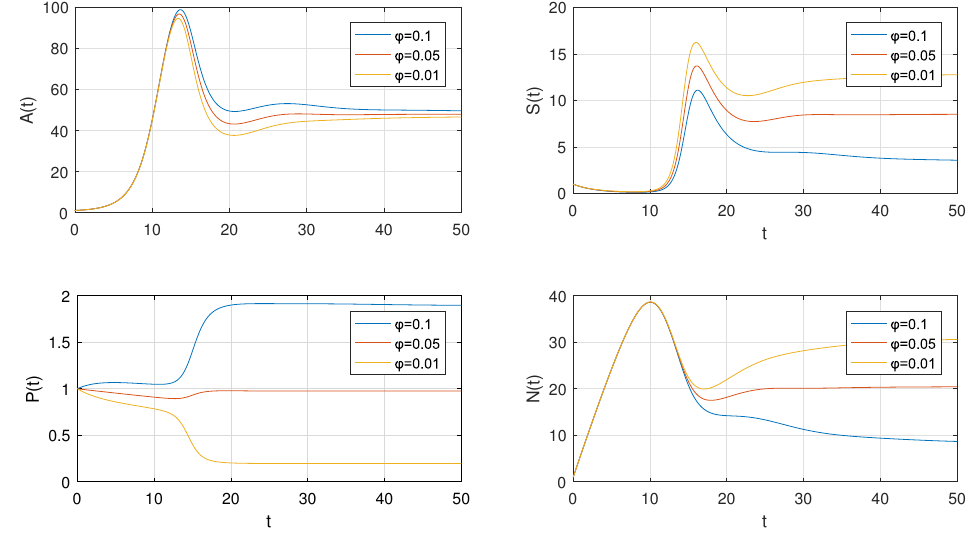
Figure 16. Numerical solution of crop model for different insecticides spraying